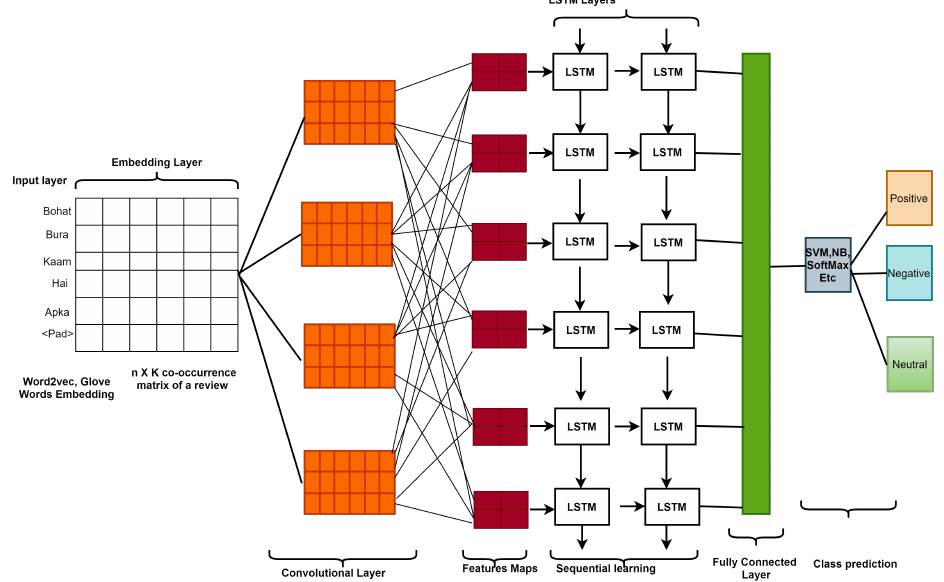
Figure 3. CNN-LSTM framework of Roman Urdu sentiment